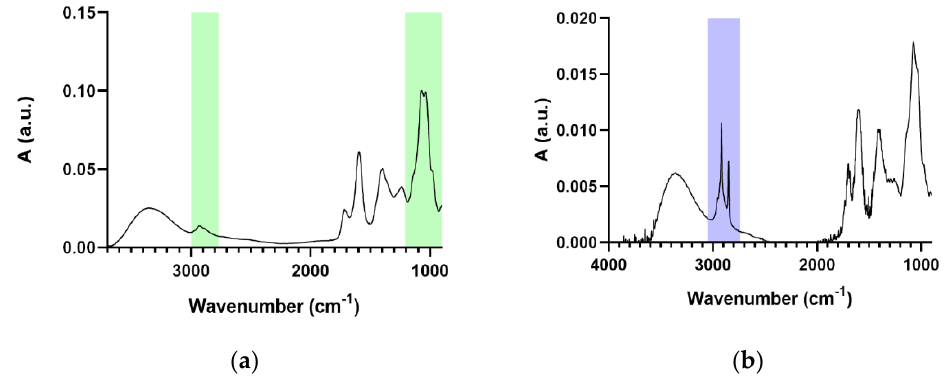
Figure 4. IR spectra of filtered ( a ) and recovered ( b ) SLNs solution.